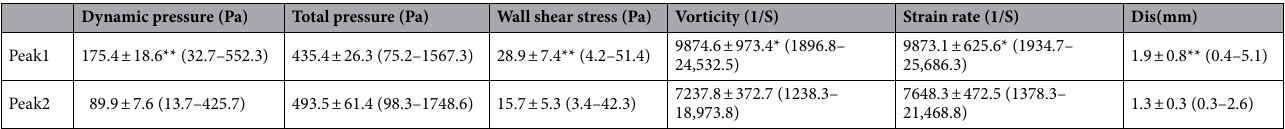
Table 4. Hemodynamic stresses at Peak 1 and Peak 2 of artery bifurcations (mean ± SD). SD standard deviation. Dis represents the distance from the peak site to the flow direct impinging center. Peak1 is on the daughter vessel forming a smaller angle with the parent artery, whereas Peak 2 is on the contralateral daughter artery. * P < 0.05 and ** P < 0.01 indicate significant differences in hemodynamic stresses between peak 1 and peak